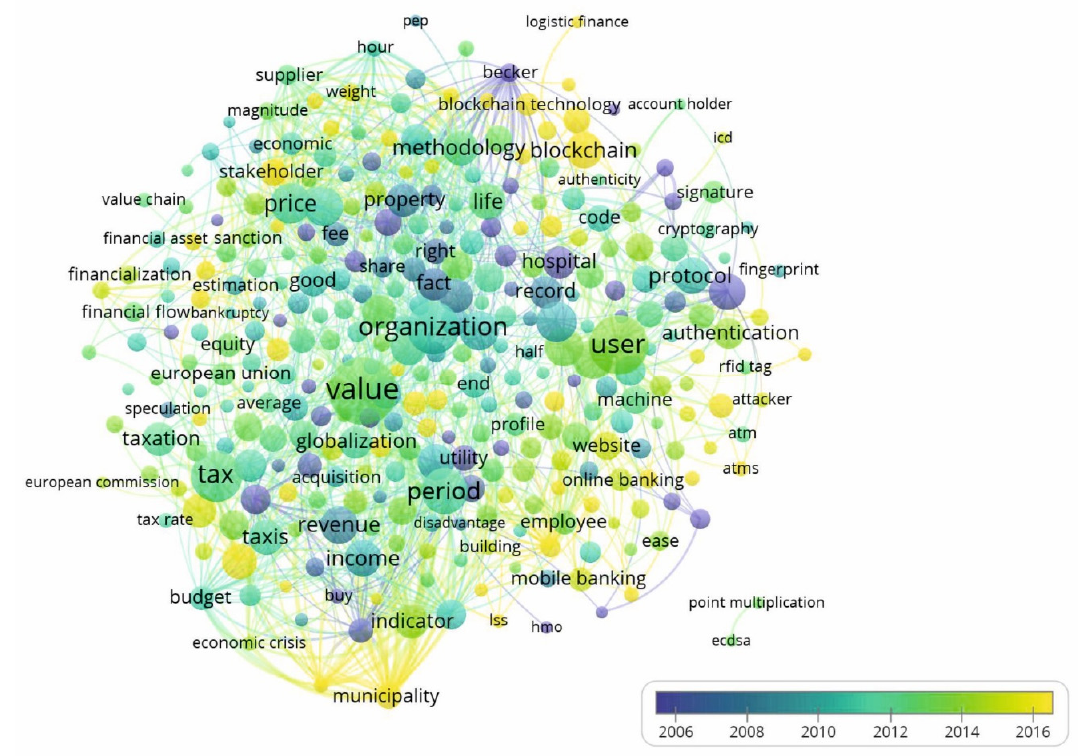
Figure 9. Evolution of the network of keywords based on co-occurrence.